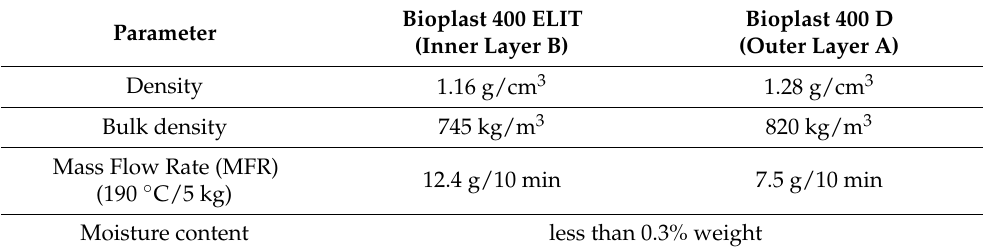
Table 2. Basic properties of biodegradable polymers used to produce CUT foil.